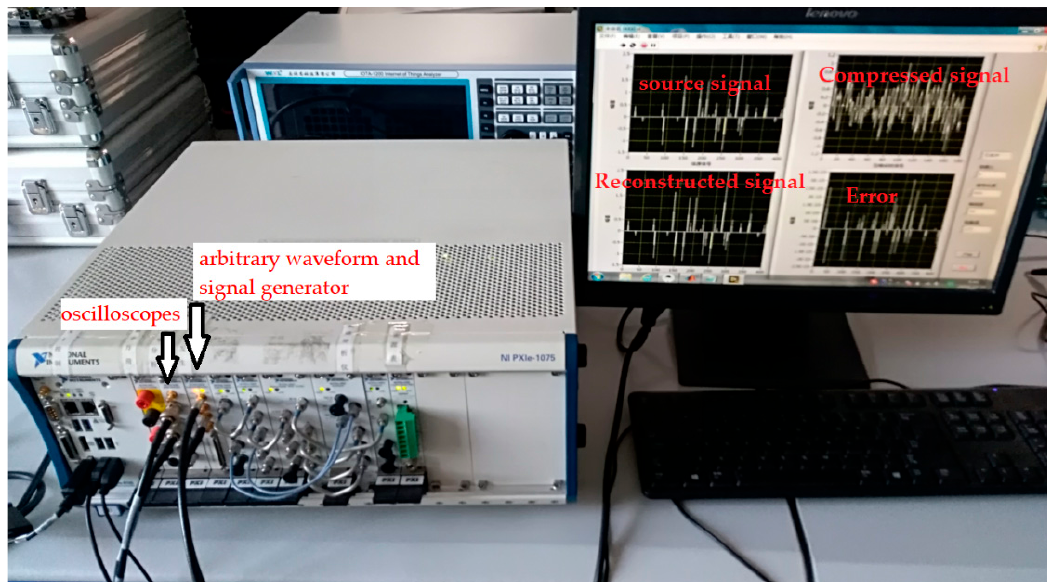
Figure 14. Peripheral component interconnect extensions for instrumentation chassis and controller.